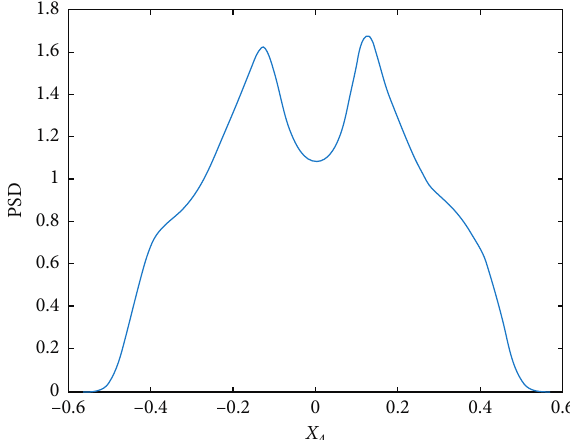
Figure 10: Probability density distributions of x